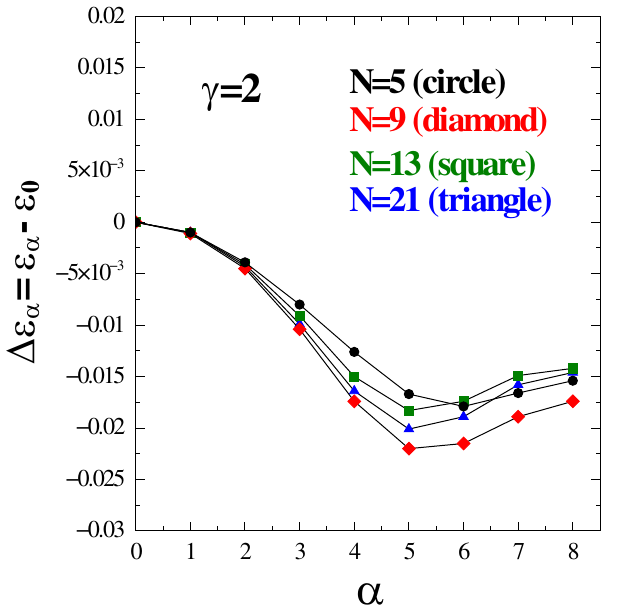
5 (black circle), N =